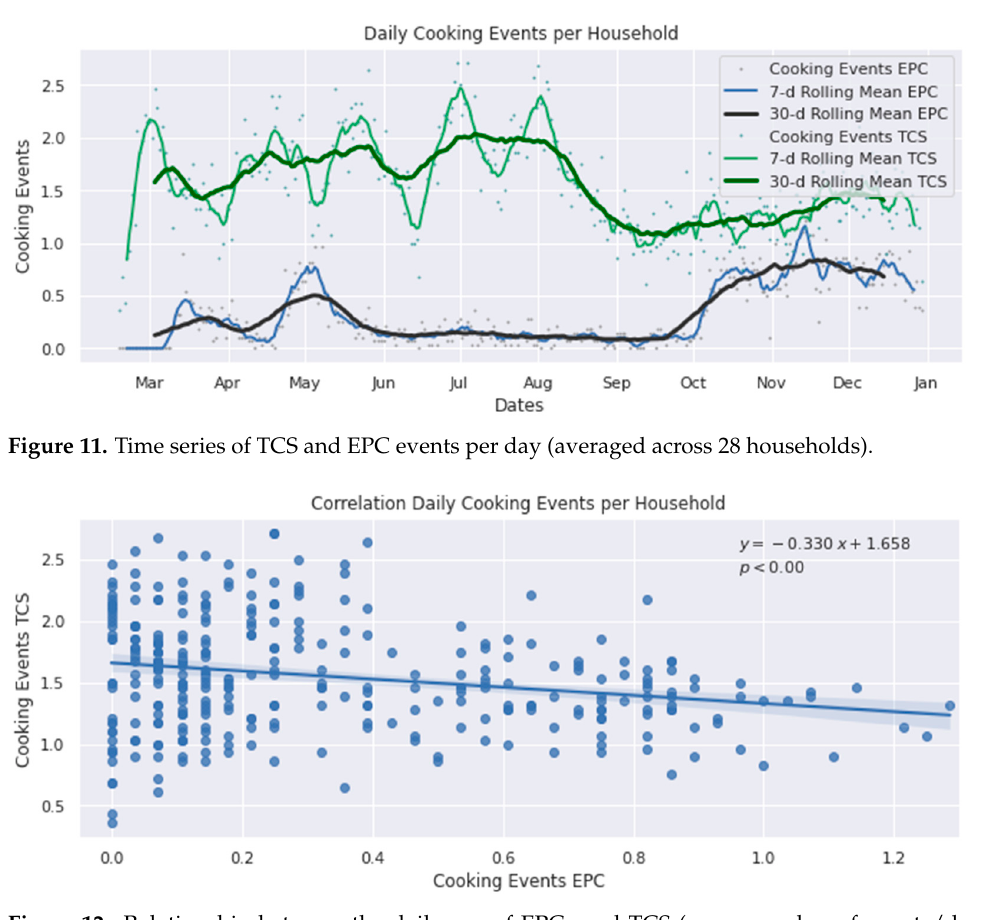
Figure 12. Relationship between the daily use of EPCs and TCS (mean number of events/day) (averaged across 28 house- holds).